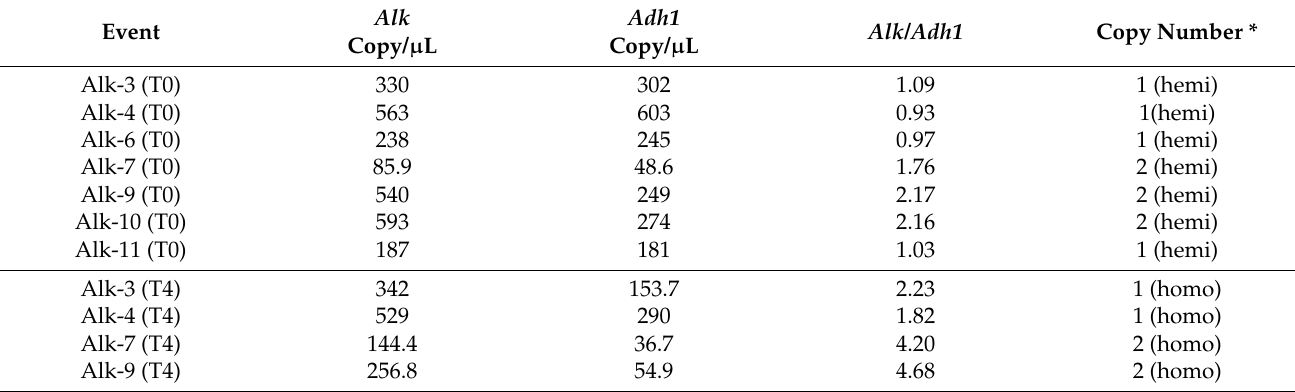
Table 3. Determination of transgene copy numbers of T0 and T4 leaf tissues using droplet digital PCR.